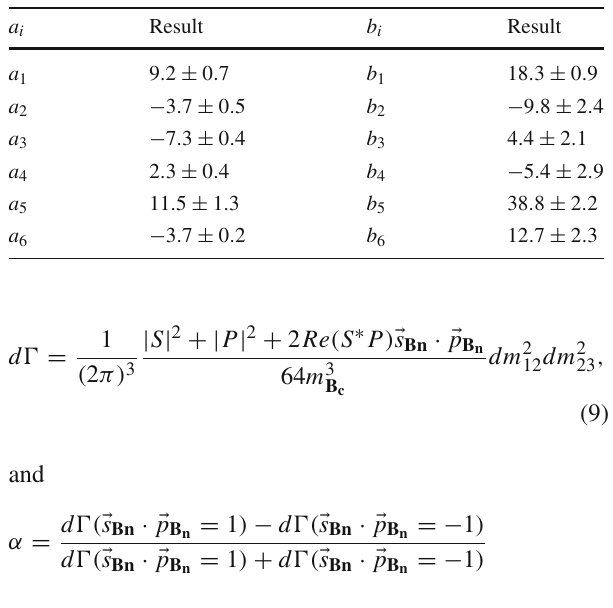
Table 6 Numerical results for (cid:3) → B B ((cid:3) + n MM c